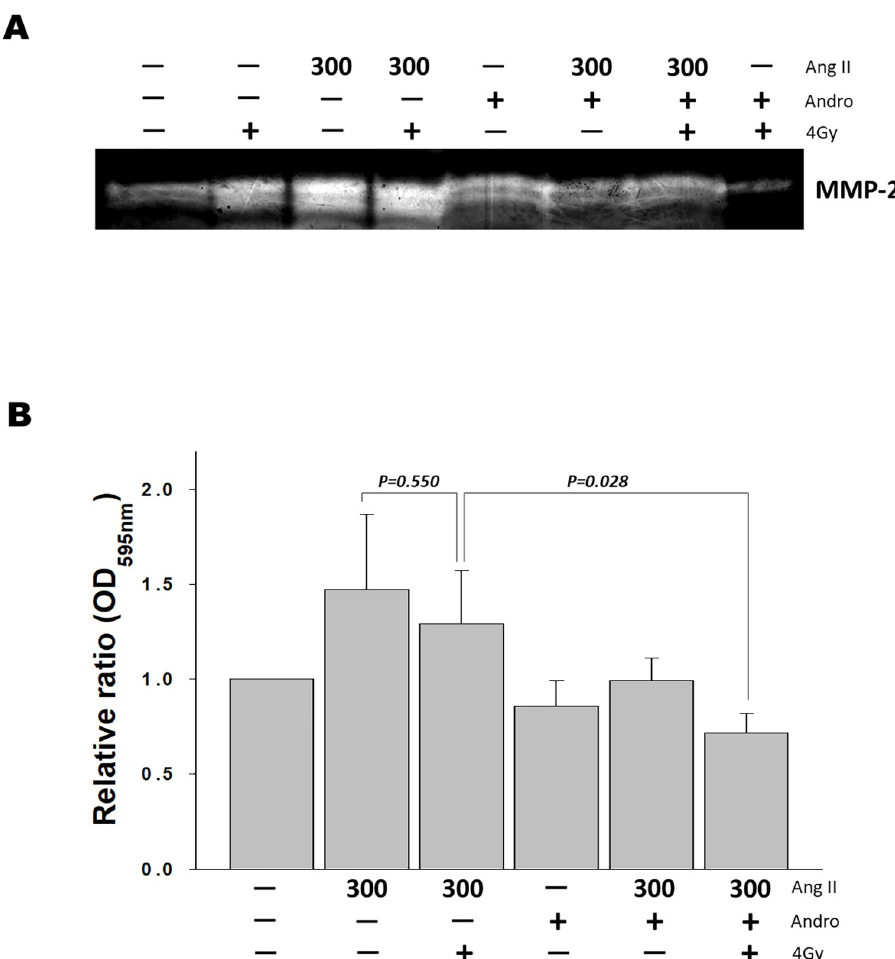
Fig 5. Andrographolide plus radiation reduced angiotensin II-induced MMP-2 activation and invasion. The Ras- transformed cells were incubated with/without 300 nM angiotensin II (Ang II) for 1 hour, and then treated with andrographolide, or radiation, or both for 24 hours. (A) The typical data show the gelatin zymography analysis band of the MMP-2 in conditioned media. (B) Invasion assays were performed using Transwell inserts of 8-micron pore size membrane and matrigel. After treatment, the cells were seeded in Transwell plates for 72 hours. The invaded cells were stained and quantified at an optical density of 560 nm. The experiments have been repeated three times; representative results of three independent experiments were shown. Quantification of cell invasion expressed as the percentage of control; one-way ANOVA was used for statistical analysis.